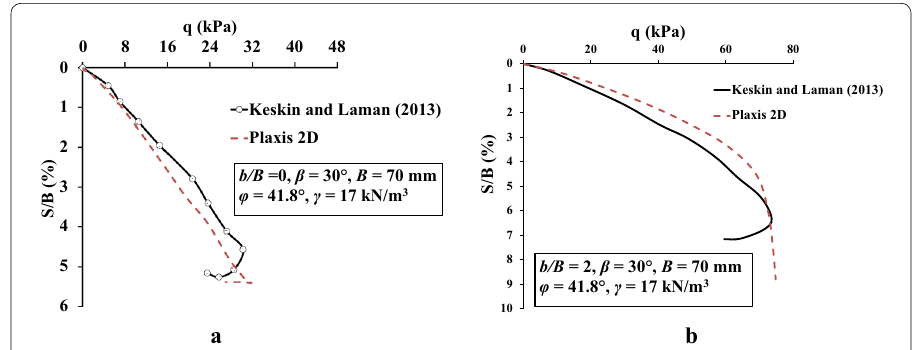
Fig. 7 Validation of the numerical model with experimental investigation done by Keskin and Laman [22] for setback ratios: ( a ) b / B 0 and ( b ) b / B 2 = =